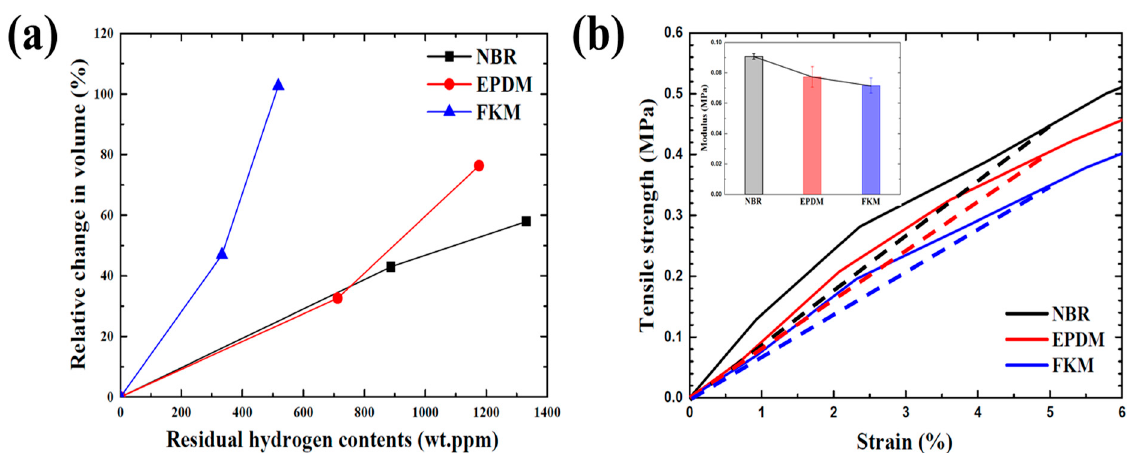
Figure 11. ( a ) Volume swelling and hydrogen content of NBR, EPDM, and FKM and ( b ) tensile modulus of NBR, EPDM, and FKM.